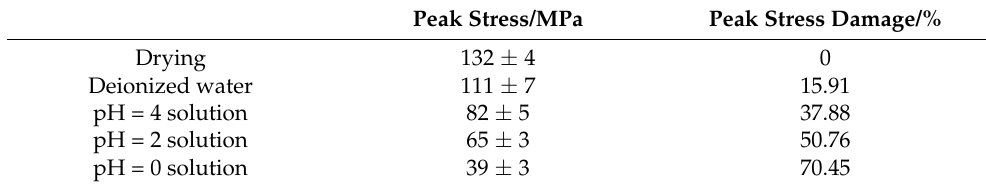
Table 2. Peak stress of different lamprophyre under uniaxial compression.